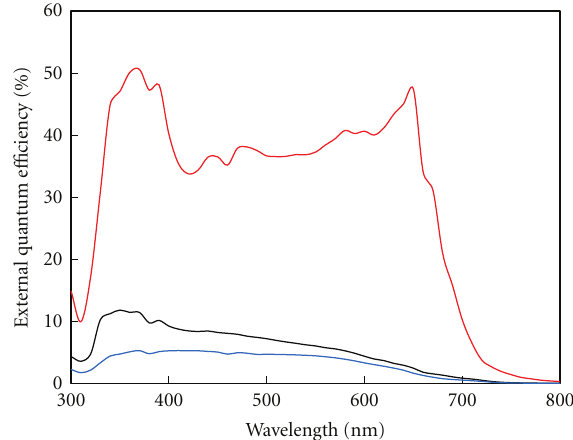
Figure 7: External quantum e ffi ciency spectra of bulk heterojunc- tion solar cells based on P1 (black), P2 (blue), and P3 (red) and PC 61